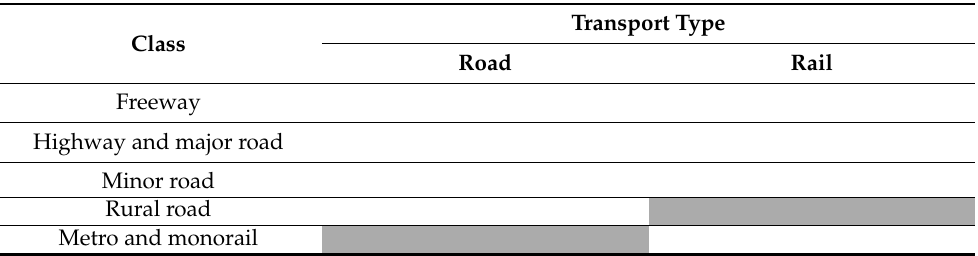
Table A6. Load impact score.